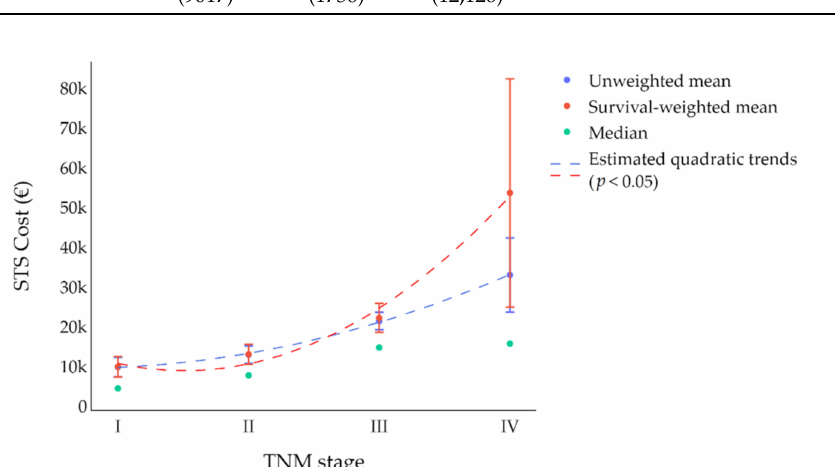
Figure 1. Survival-weighted and unweighted mean, median and polynomial regression estimates of costs of managing STS by TNM